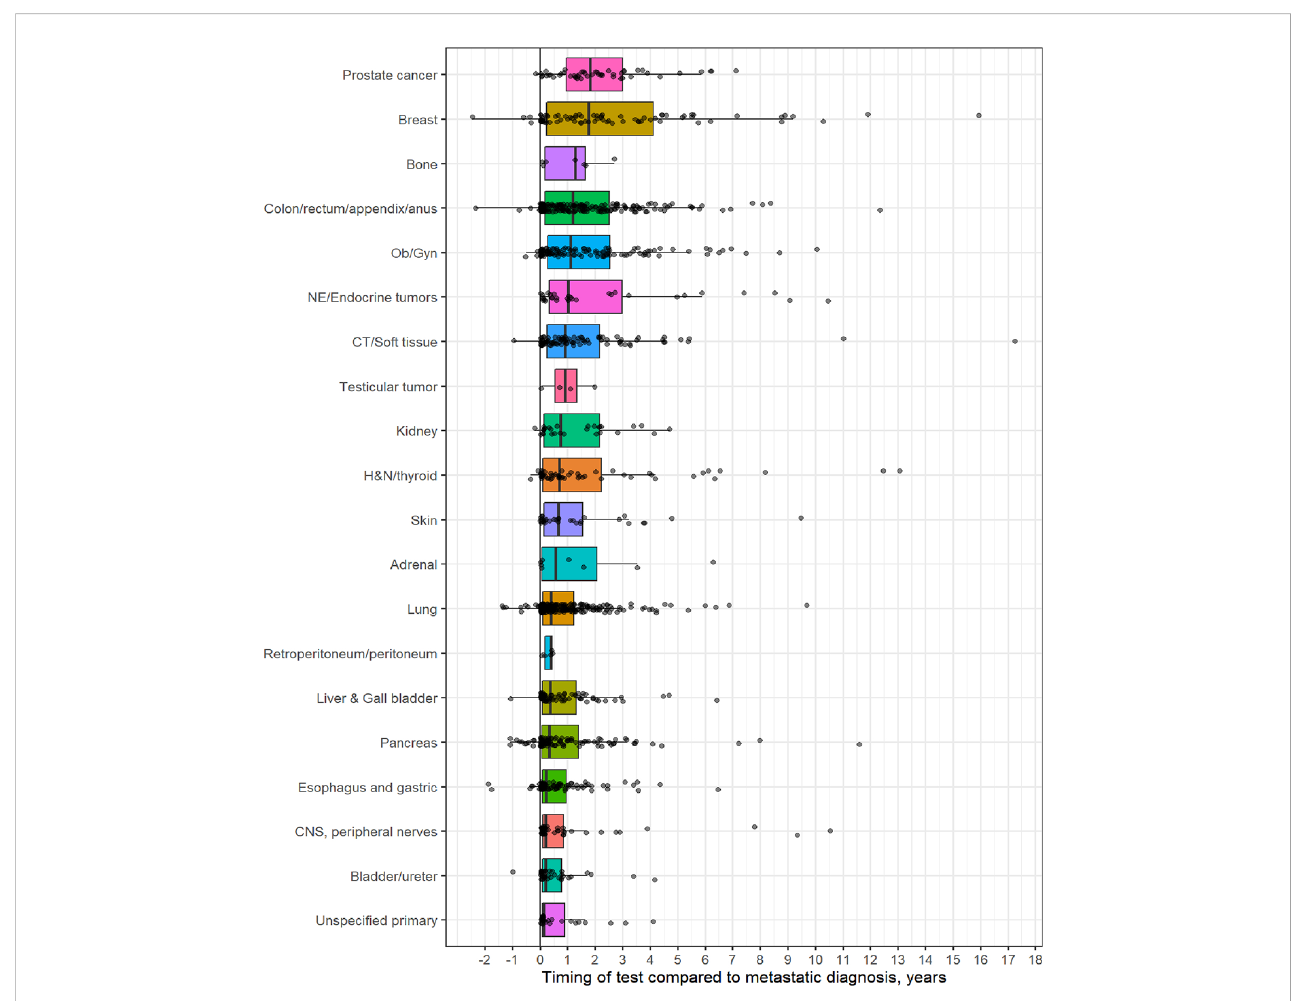
FIGURE 1 Distribution of comprehensive genomic pro fi ling (CGP) test for each diagnostic category (Y-axis) to timing of CGP test (X- axis, time in years). On X-axis, 0 represent time of metastatic diagnosis and grey dots depicts timing of CGP test with respect to each diagnostic